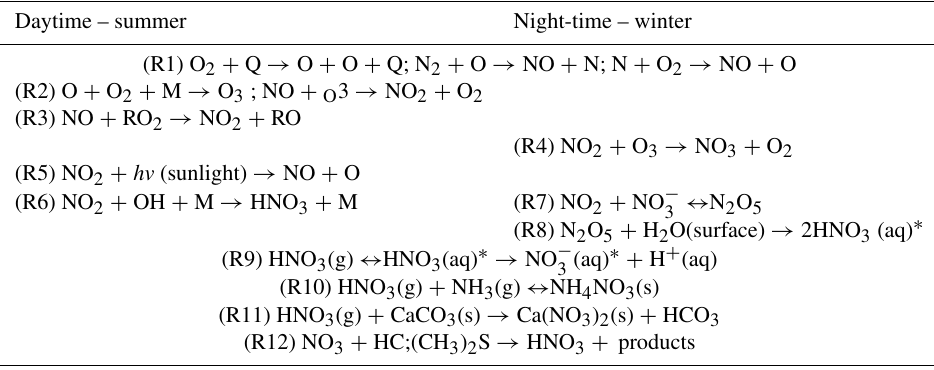
Table 5. Main reactions producing atmospheric nitrates (Zel’dovich, 1946; Lavoie et al., 1970; Erisman and Fowler, 2003; Michalski et al., 2003; Morino et al., 2006; Morin et al., 2007; Stroud, 2008; Michalski et al., 2014). Reactions (R1) and (R9–R12) can occur any time. Daytime – summer Night-time –